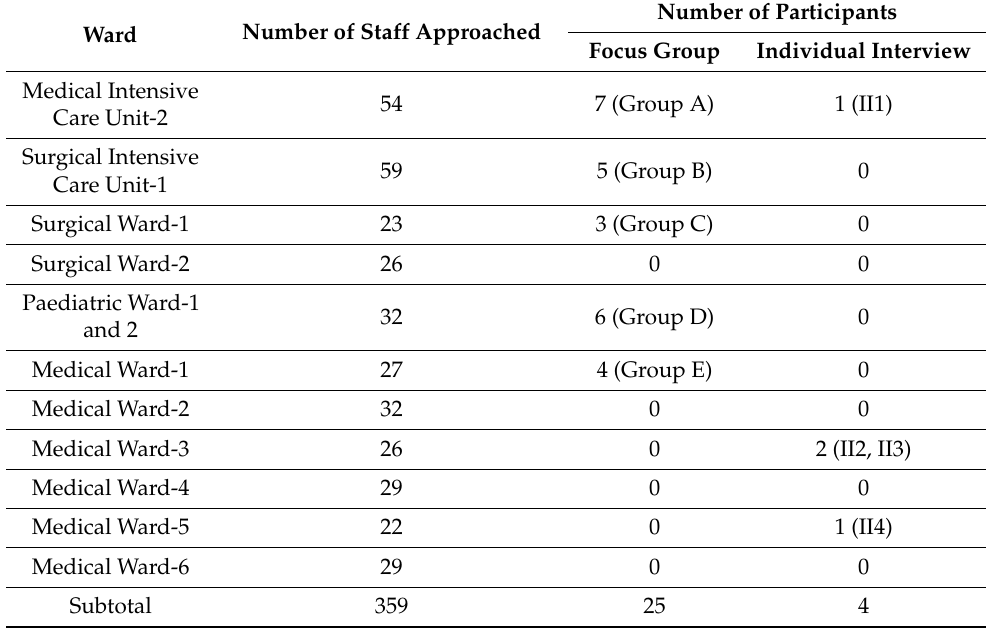
Table 2. Recruitment results of focus groups and in-depth interviews.